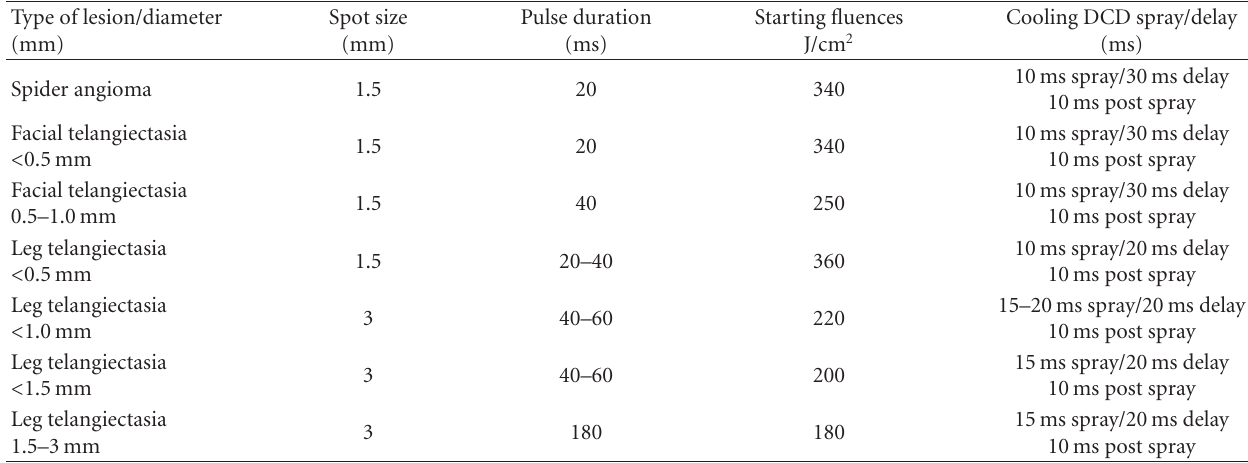
Table 1: Treatment procedures according to type and diameter of